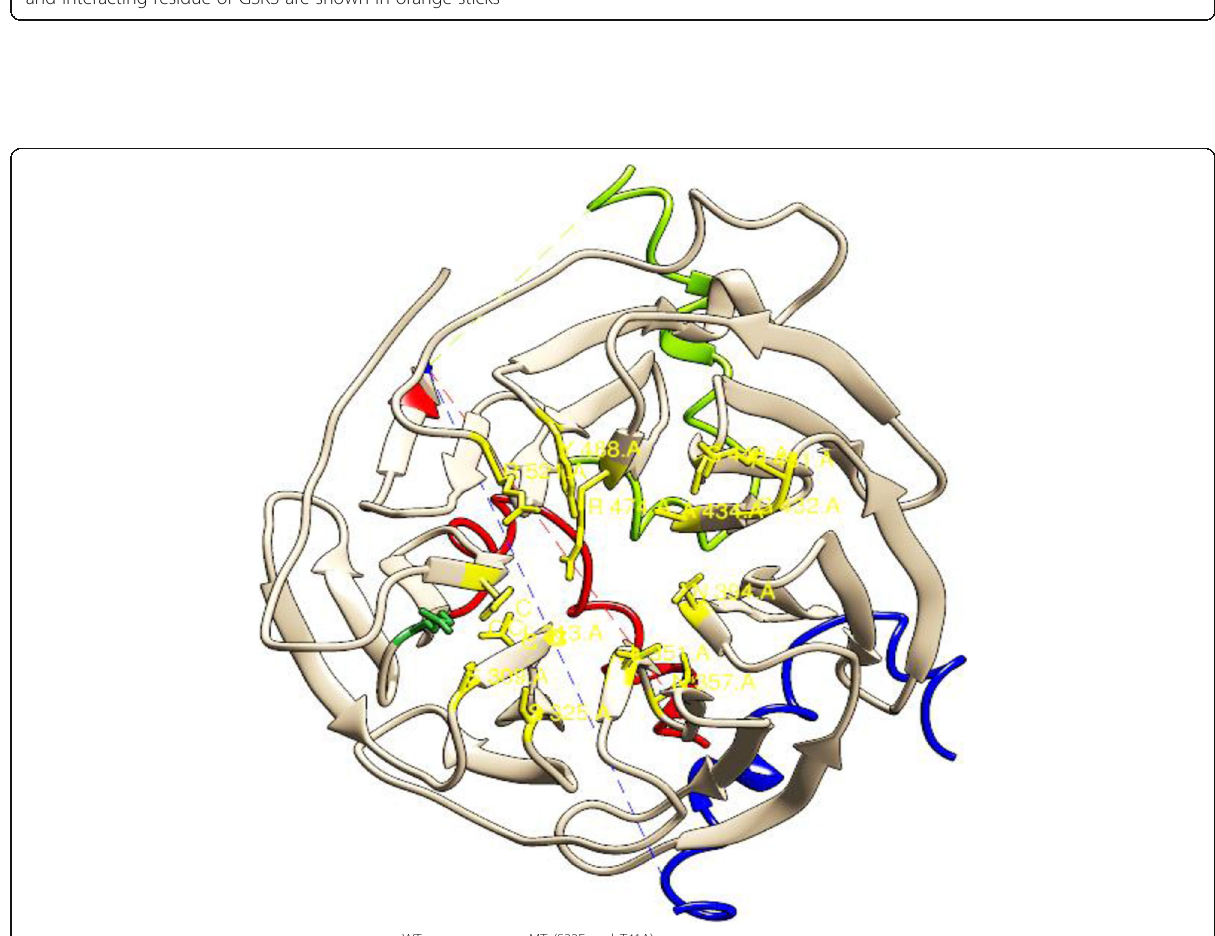
Fig. 7 Molecular docking complex of CTNNB1 WT and CTNNB1 MT (S33F and T41A) with TrCP1. TrCp1 is shown in tan colour ribbon with interacting residues of narrow channel shown in yellow sticks. Wild type destruction motif of CTNNB1 is shown in red ribbon and loop form. S33F mutant CTNNB1 motif is shown in blue and T41A mutant is shown in green